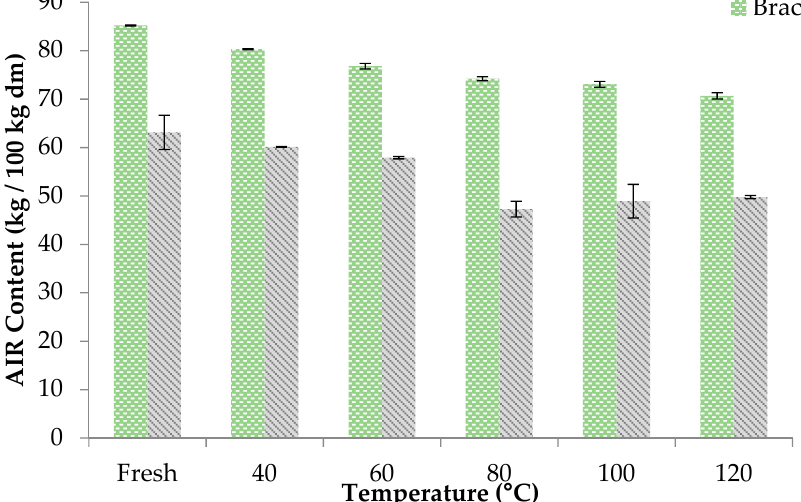
Figure 2. Alcohol insoluble residue (AIR) content of bracts and stems samples after to be dried at different temperatures.